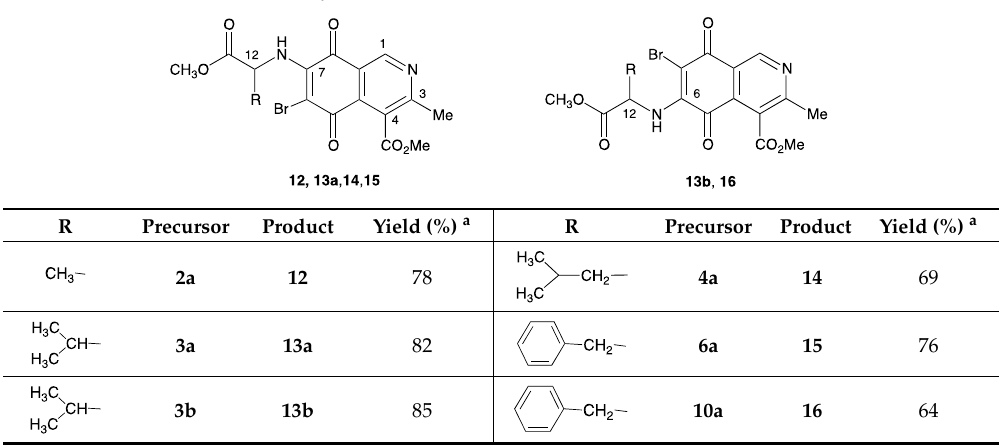
Table 2. Yields of the synthesized bromine derivatives 12 , 13a , 13b , 14 , 15 , and 16 .